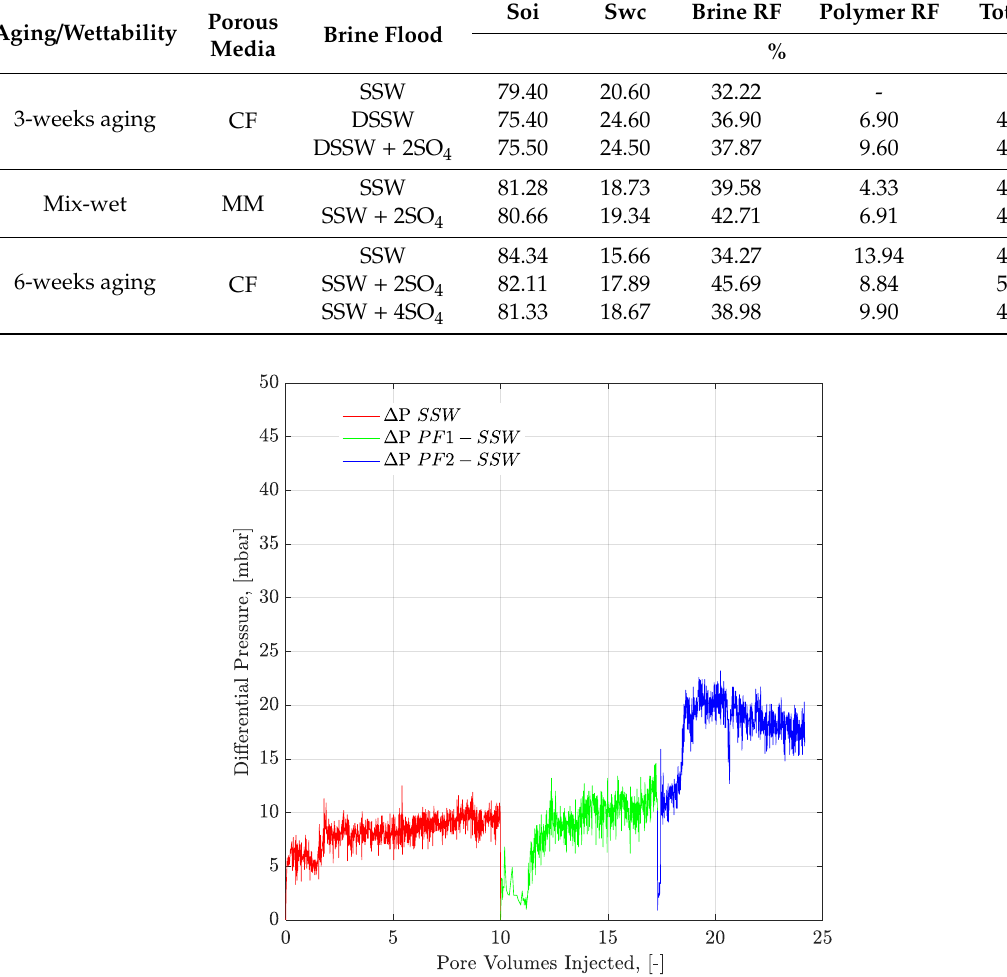
Figure 16. Pressure drop versus PV injected for complex-wet micromodel. PF1 (polymer half to the oil viscosity) and PF2 (polymer equal to the oil viscosity) flooding after the brine flood in secondary mode. ∆ P SSW represents the pressure drop for synthetic seawater. ∆ P PF1-SSW represents the pressure drop of polymer injection prepared in synthetic seawater having viscosity half to the oil and ∆ P PF2-SSW shows pressure drop of polymer injection prepared in synthetic seawater having viscosity equal to the